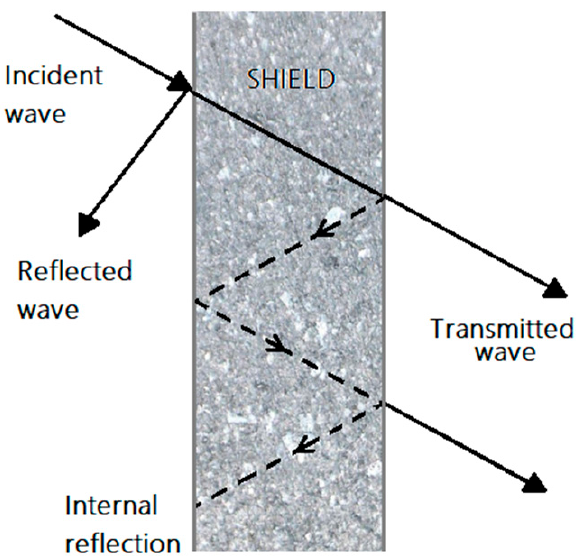
Figure 2. Diagram of transition of an incident electromagnetic wave through a material. Own compilation based on [17].